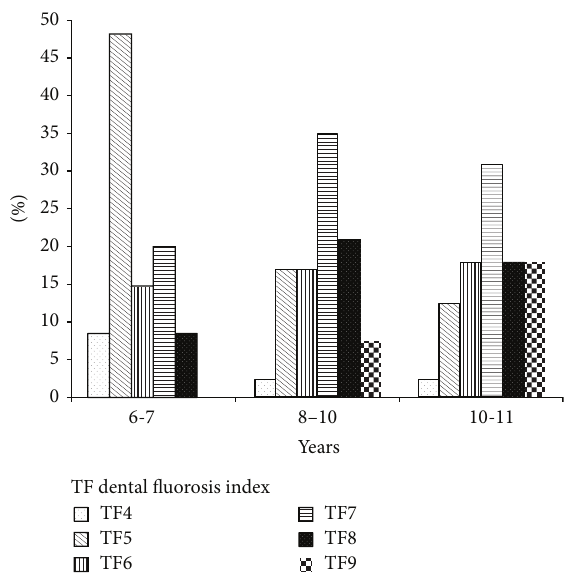
Figure 2: Distribution of dental fluorosis according to the TF index by age group as percentage.